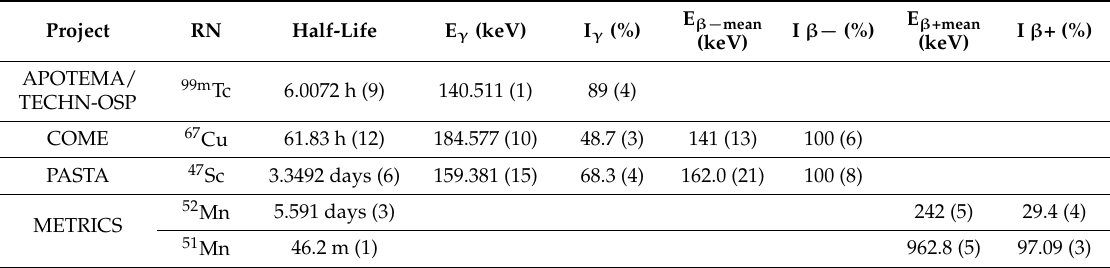
Table 2. Nuclear data of interest associated to the investigated radionuclides (RN)